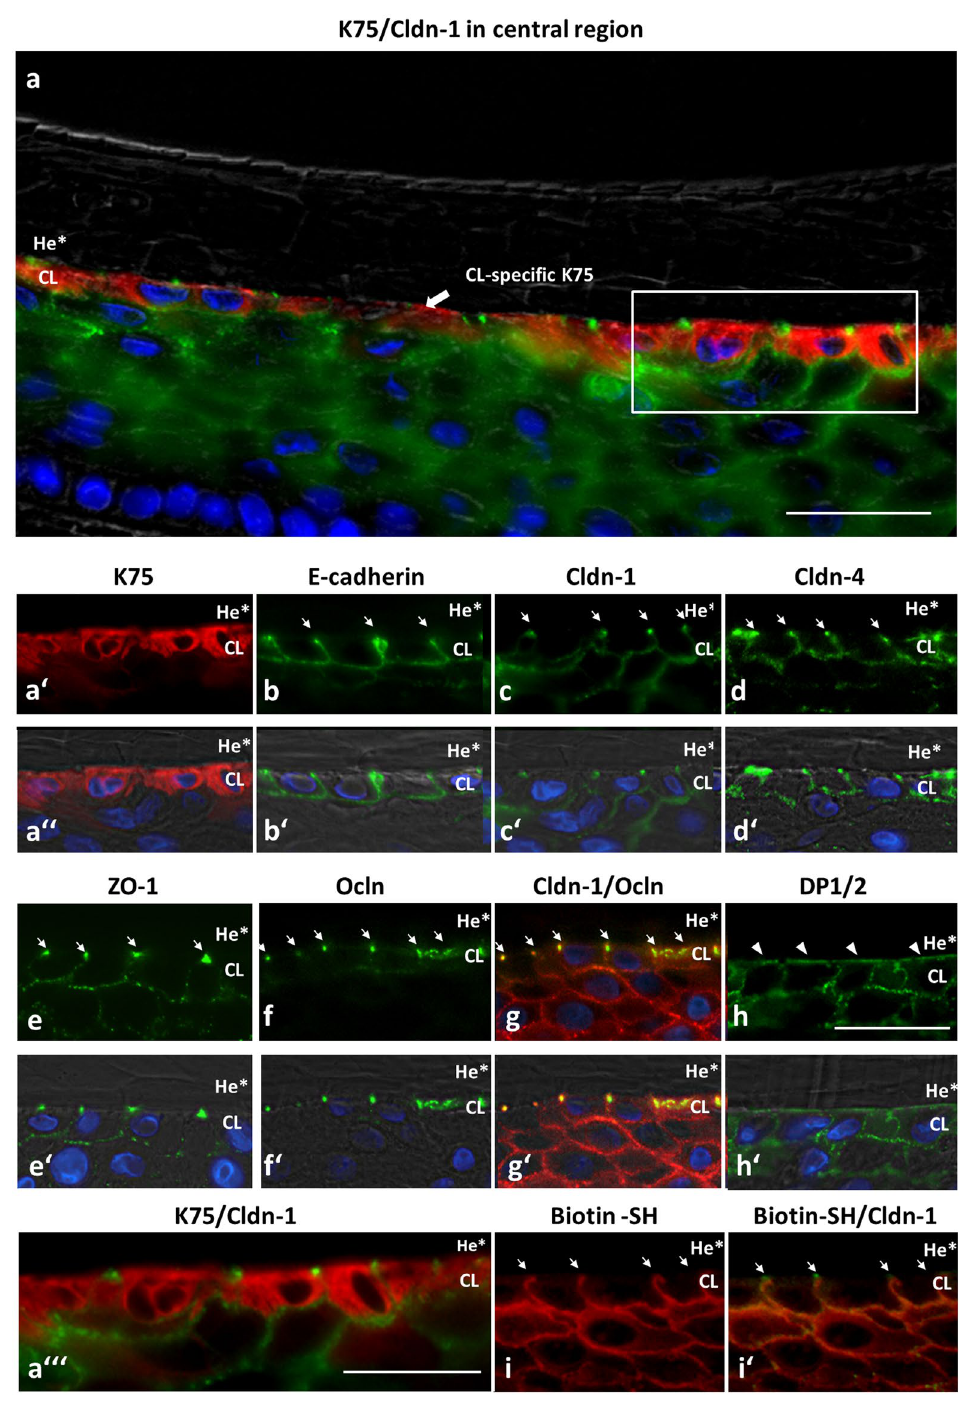
Figure 2. Identification of the CL via the marker protein K75 and demonstration of CL polarization by distinct localization of several junctional proteins. Immunohistochemical stainings of K75 (red, a ,a ′ ,a ′′ ,a ′′′ ), Cldn-1 (green, a ,a ′′′ , c ,c ′ ,i ′ respectively red, g ,g ′ ), E-cadherin (green, b ,b ′ ), Cldn-4 (green, d ,d ′ ), ZO-1 (green, e ,e ′ ), Ocln (green, f ,f ′ , g ,g ′ ), Desmoplakin (DP) 1/2 (green, h ,h ′ ) and Biotin-SH (red, i ,i ′ ) in the CL of the central region of anagen HFs. Note the polarized distribution of the junctional proteins and the stop of paracellular flux at functional TJs located at the apical sites of the lateral plasma membranes (arrows in b–g, i, i ′ ) of the CL bordering to the differentiated He * layer. Arrowheads in h denote the apical localization of DP 1/2. ( a ,a ′′ , b ′ –h ′ ) Overlay images with DAPI staining (blue nuclei) as well as phase contrast. Scale bars: 20 μ